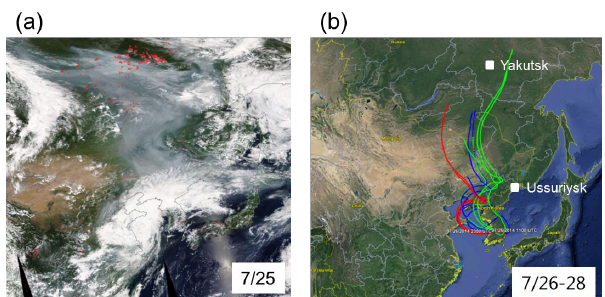
Figure 3. (a) MODIS RGB image on 25 July 2014 and (b) air mass backward trajectories between 26 and 28 July 2014 when smoke plumes originating from Siberian forest fires had an impact on the Korean Peninsula. Red, blue, and green in (b) represent air mass backward trajectories arriving at 200, 500, and 1000m heights, re- spectively. The Yakutsk site (61.66 ◦ N, 129.37 ◦ E) and Ussuriysk site (43.70 ◦ N, 132.16 ◦ E) in (b) are AERONET sites in